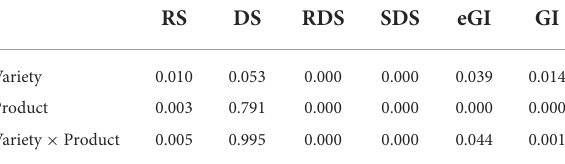
TABLE 3 Test of between-subjects effect of in vitro and in vivo parameters as influenced by yam variety and